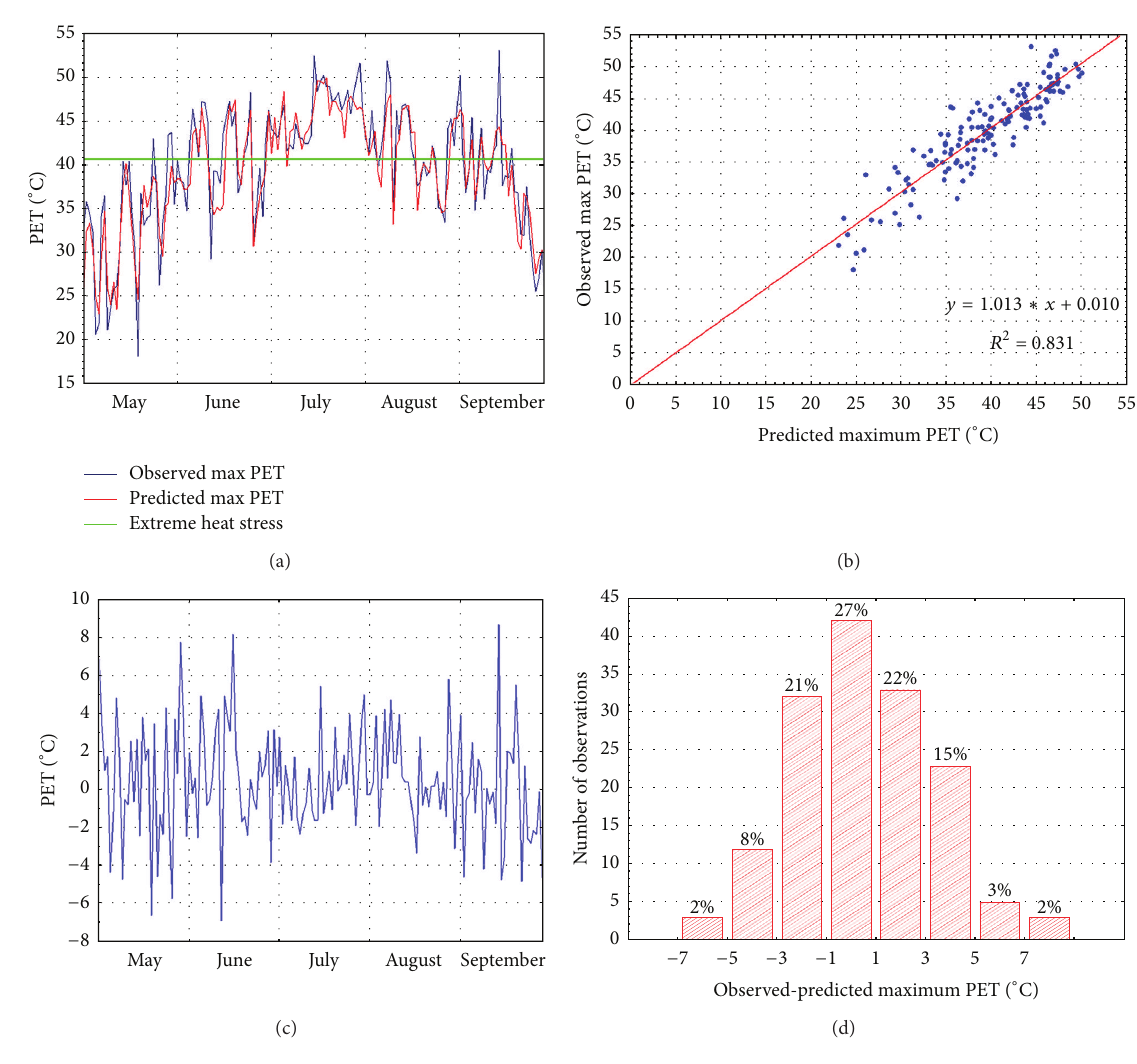
Figure 6: Observed versus predicted daily maximum PET values (a); scatter plot between observed versus predicted daily maximum PET values (b); observed minus predicted daily maximum PET values (c) and histogram with the absolute differences between the observed and the predicted daily maximum PET values (d). One day ahead prognosis. Warm period of 2011.